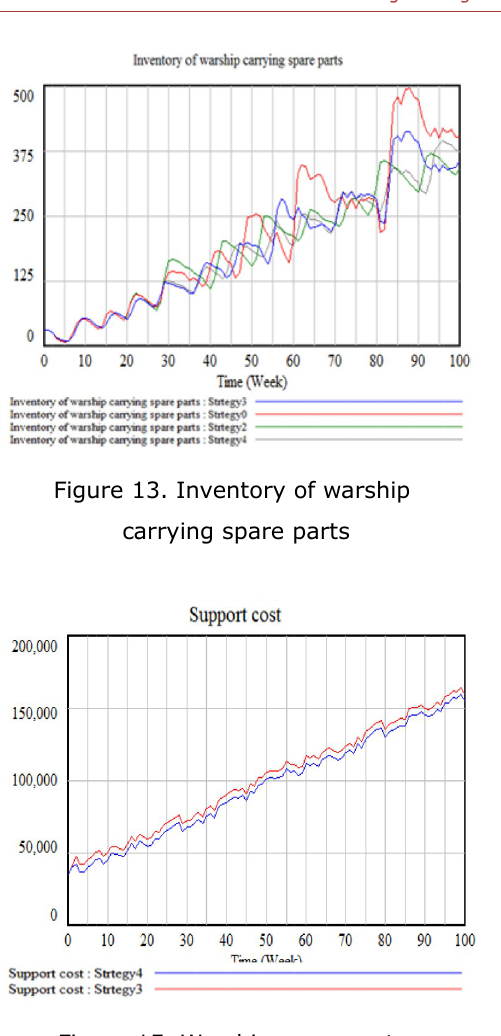
Figure 16.Warship operational availability